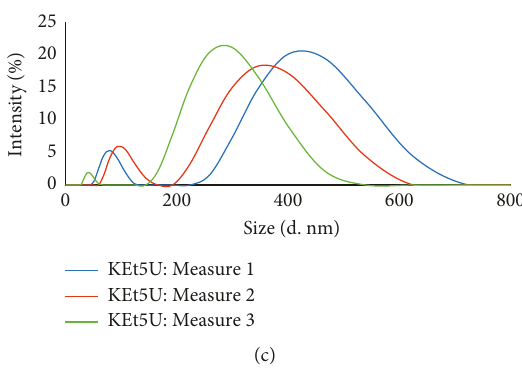
Figure 11: The particle size distribution of the KC (a), KEt5U (b), and KEt5M (c) samples. Table 3: Particle sizes of the recrystallized samples. Samples Z -average (nm) KC